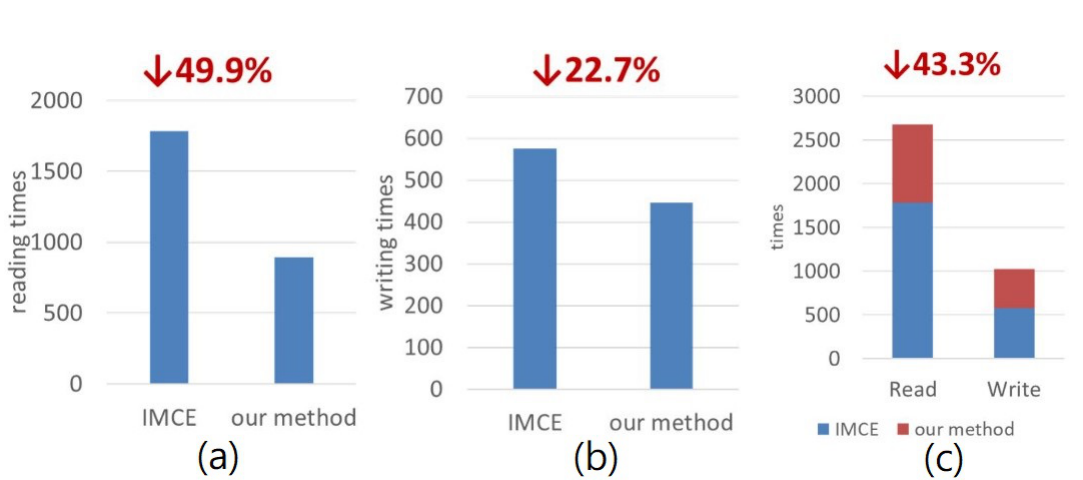
Figure 15. ( a ) Reading times, ( b ) writing times, and ( c ) comparison.